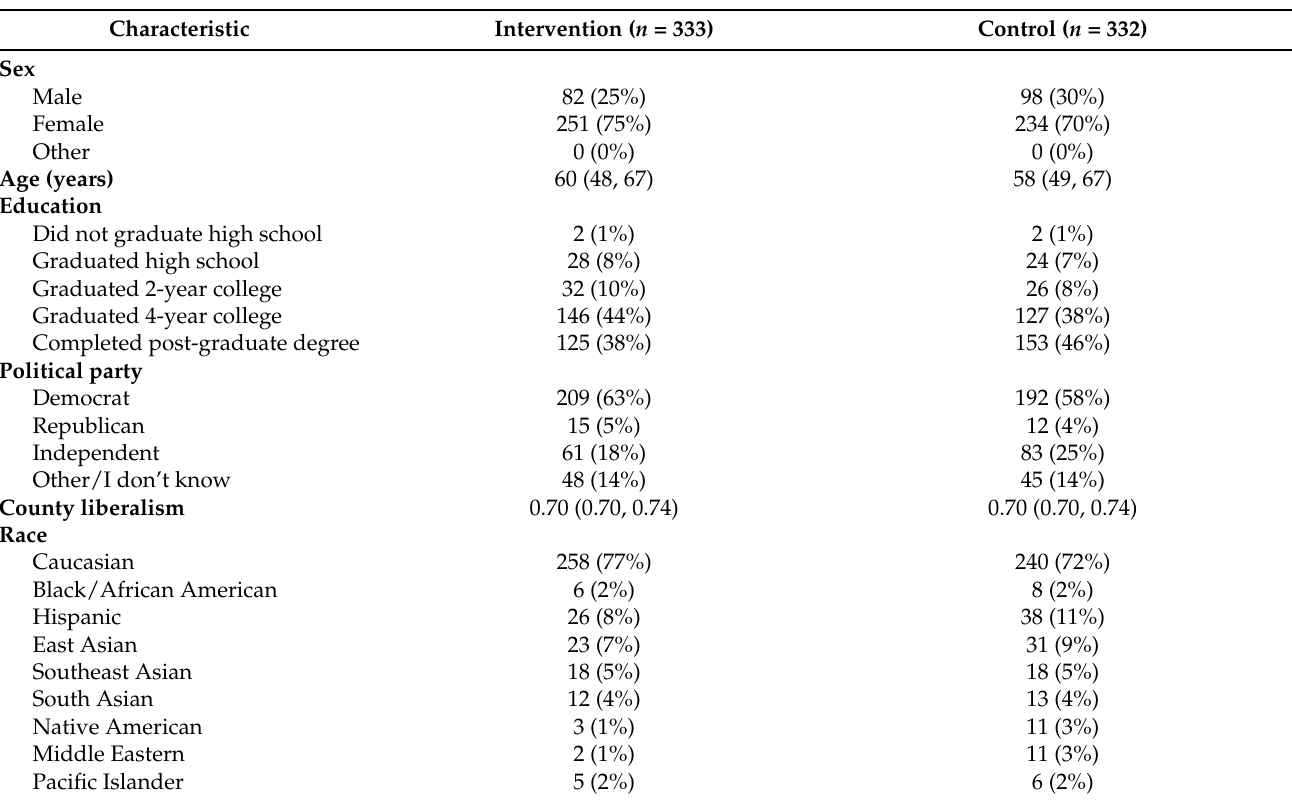
Table 4. For Study 3, demographic characteristics of the 665 participants at baseline. Continuous variables are reported as medians with 25th and 75th percentiles. Binary variables are reported as counts and percentages. Participants could indicate multiple races. “County liberalism”: in the participant’s county, the proportion of votes from the 2000–2016 United States presidential elections that went to the Democratic